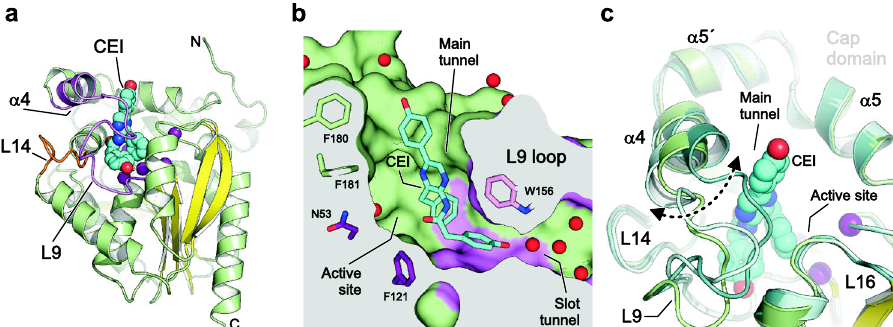
Fig. 5 Structural characterization of coelenteramide binding to the catalytically defective RLuc8-W121F/E144Q mutant. a Cartoon representation of the overall structure of the RLuc8-W121F/E144Q mutant with coelenteramide (CEI) in its active site. CEI is the product of the LUC reaction and shown as cyan space- fi lling spheres. Residues of the conserved catalytic pentad are shown as purple spheres; the central eight-stranded β -sheet is coloured yellow; the α 4 helix and L9 loop (L9- α 4 element) are coloured violet, and the L14 loop is coloured orange. b Cutaway surface representation of the enzyme active site cavity with the bound CEI (shown as cyan sticks). The colouring is the same as in panel ( a ). Water molecules are shown as red spheres. c Close-up view of structural superposition of RLuc8-W121F/E144Q (green), RLuc8 (PDB ID 2PSF A; cyan) and RLuc8 (PDB ID 2PSF B; teal). CEI is shown as cyan space- fi lling spheres. Note the conformational sampling of the L9- α 4 fragment. The bottom 4-hydroxyphenyl group connected to the CEI acetamide moiety is deeply buried in the active site cleft, where it is anchored in the slot tunnel through multiple hydrophobic (P224, I223 and I266) and aromatic π -stacking (W156) interactions. The 4-hydroxyphenyl group interacts with the indole NH group of W156 through a water-mediated hydrogen bond bridge. The acetamide moiety of CEI is positioned close to the conserved catalytic centre. In chain B, the top 4-hydroxyphenyl group linked with the CEI pyrazine ring interacts with a side chain of K189 through a water-mediated hydrogen bond bridge and forms a hydrogen bond with the carboxylate group of D162 from a symmetry-related enzyme